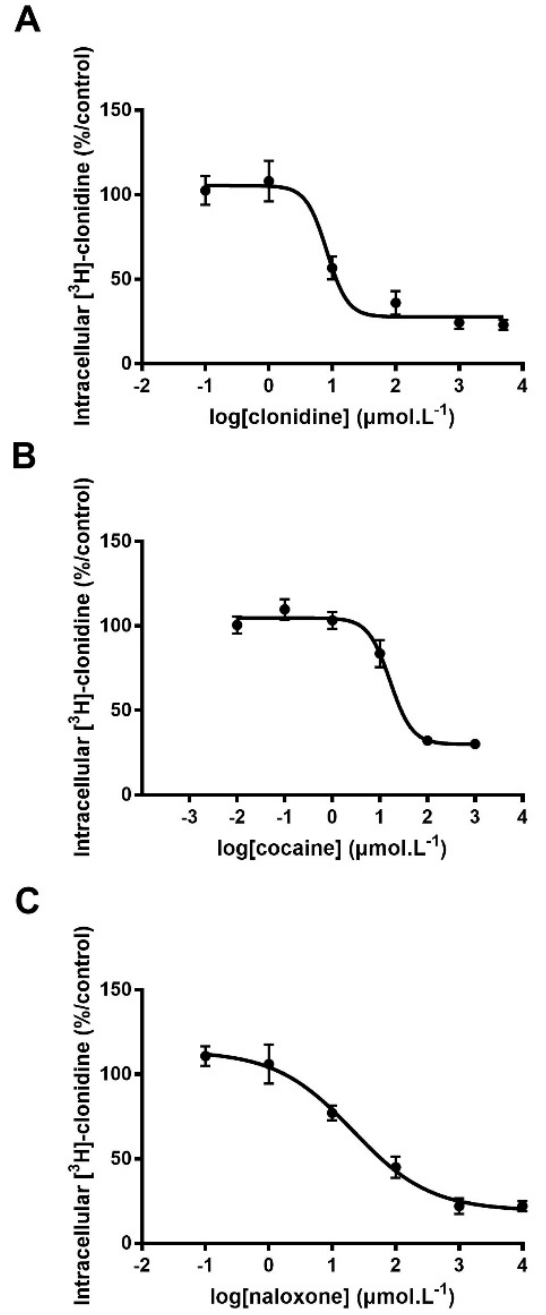
Figure 1. Trans-stimulation studies of [ 3 H]-clonidine transport in hCMEC/D3 cells. hCMEC/D3 cells were first loaded with [ 3 H]-clonidine for 5 min and then washed and incubated with Krebs-HEPES (KH) buffer alone (control; 100%) or with the unlabeled test compound in KH buffer at 6 concentrations from 0.01 to 1000 µmol·L − 1 . Compounds tested were clonidine (panel A ), cocaine (panel B ) and naloxone (panel C ). Data represent means ± SD of experiments performed in triplicate. The TSE 50 for clonidine, cocaine, and naloxone in [ 3 H]-clonidine trans-stimulation experiments in hCMEC/D3 cells was fitted according to Equation (1).